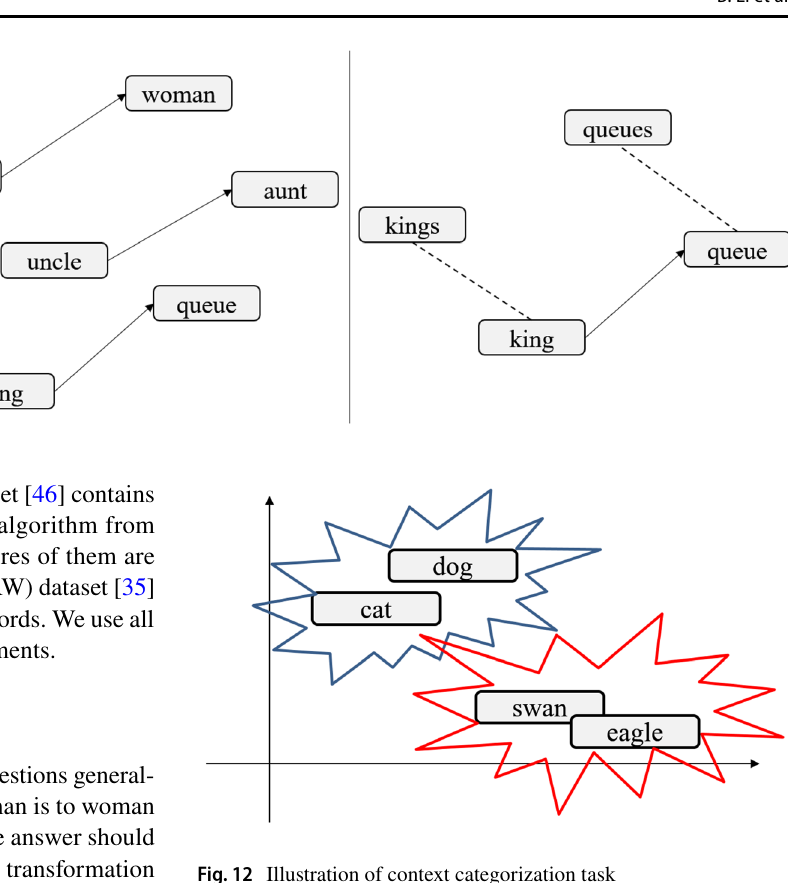
Fig. 12 Illustration of context categorization task Table 5 Summary of datasets used in concept categorization task